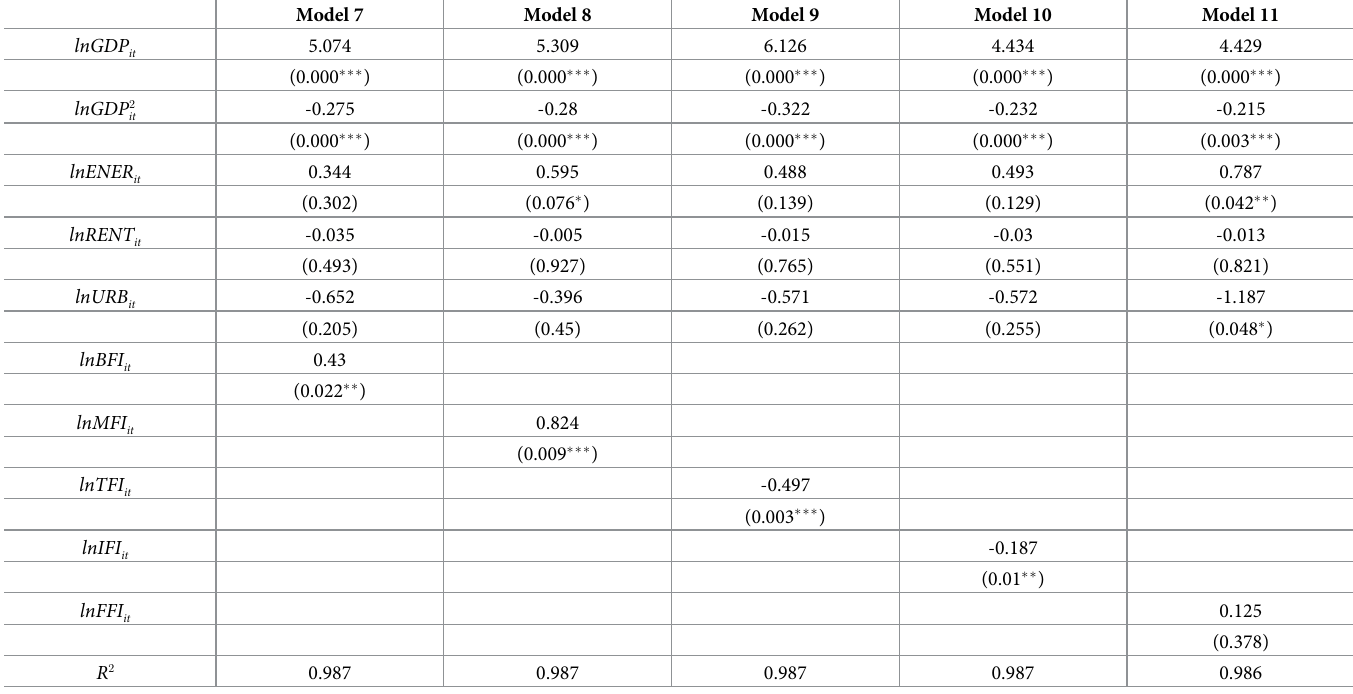
Table 8. Estimation of PFMOLS Model for long run effect when variables are